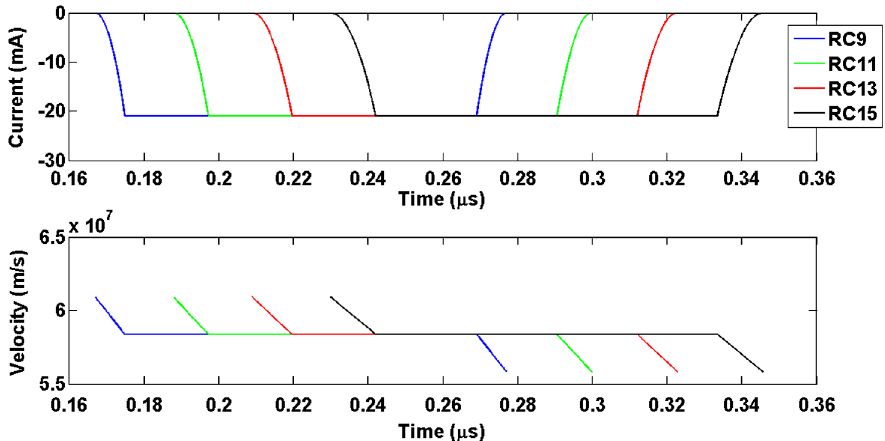
FIG. 3. Analytical current and velocity profiles calculated using the self-similar one-dimensional solution on the first turn, at RC9, RC11, RC13, and RC15 for the 21 mA beam.